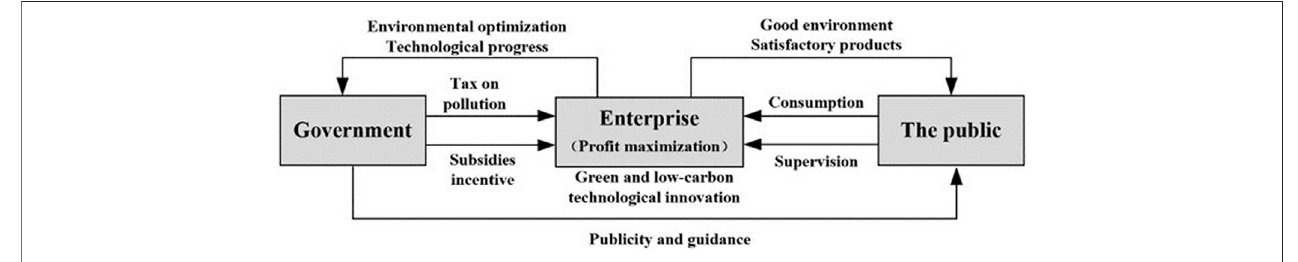
FIGURE 1 | Relationship between the